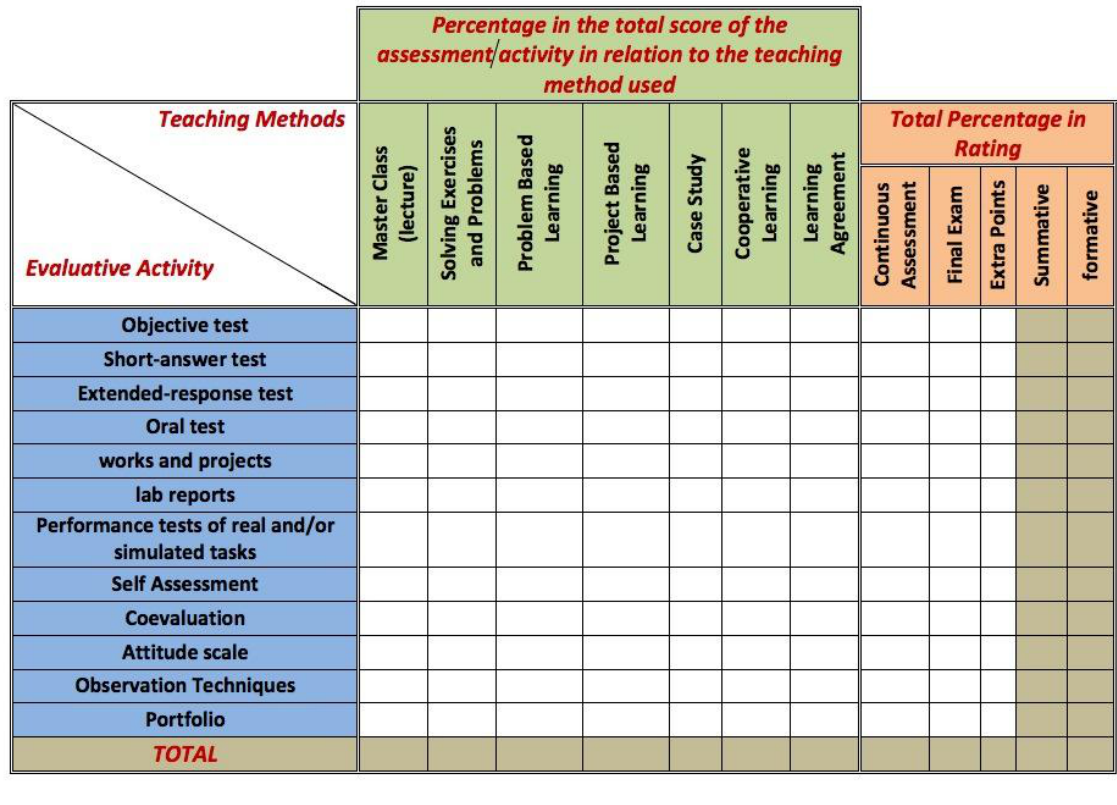
Fig. 5. Assessment methods card.